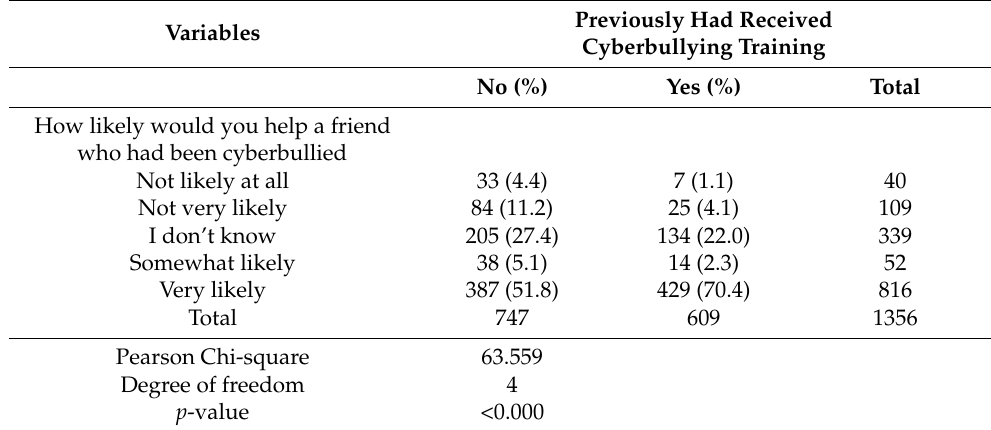
Table 3. Chi-square test ( n = 1356).